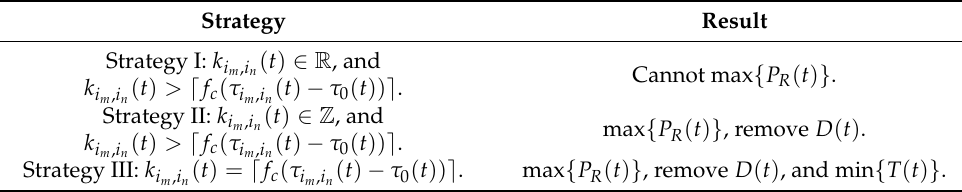
( t ) strategies. Table 4. Comparison between different k i m , i n Strategy